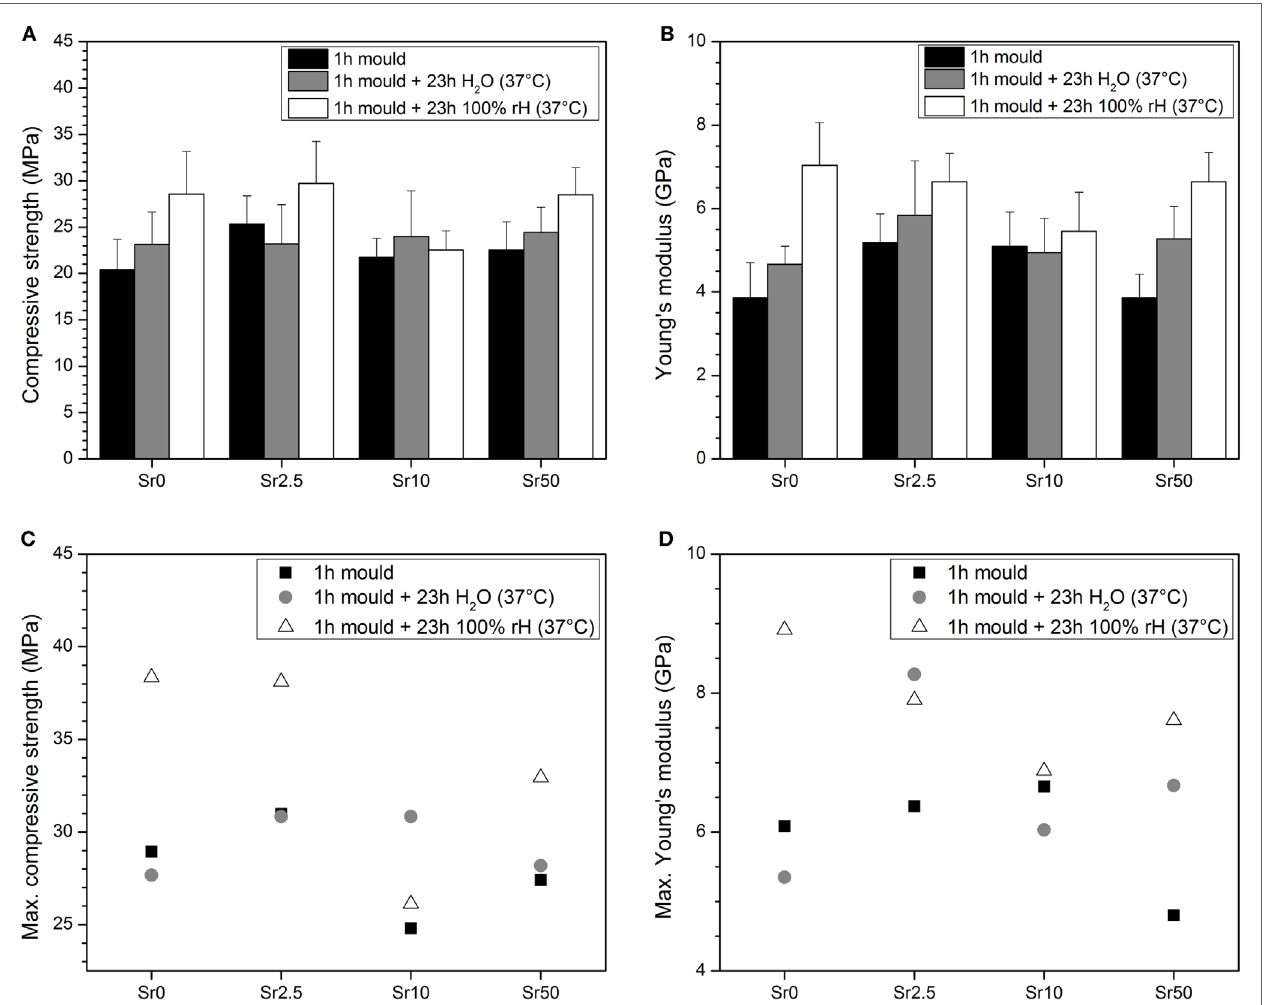
FigUre 4 | Mean (a) compressive strength and (B) elastic modulus and maximum (c) compressive strength and (D) elastic modulus obtained from compression tests on cement samples